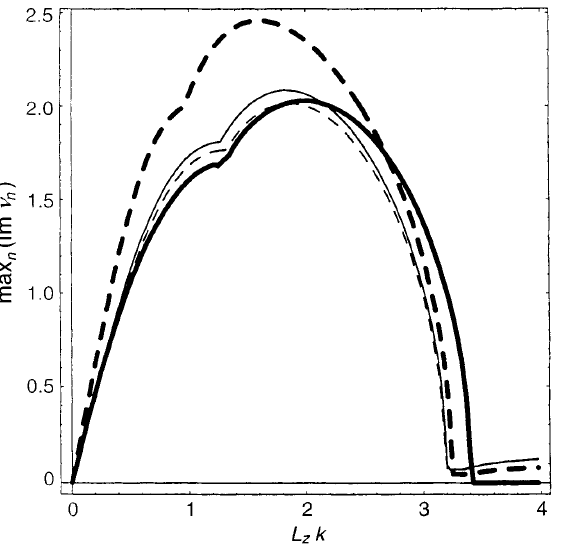
Fig. 2. The growth rate max n (cid:133) Im m n (cid:134) for marginally thin sheets (cid:133) q = L z (cid:136) 1 : 05 (cid:134) as a function of the wave number, depicted by a o ; j thick solid line , a thick dashed line , a thin solid line and a thin dashed line for four di(cid:128)erent mass ratios M (cid:136) l (cid:255) 1 (cid:136) 1 ; 4 ; 16 ; and 64,